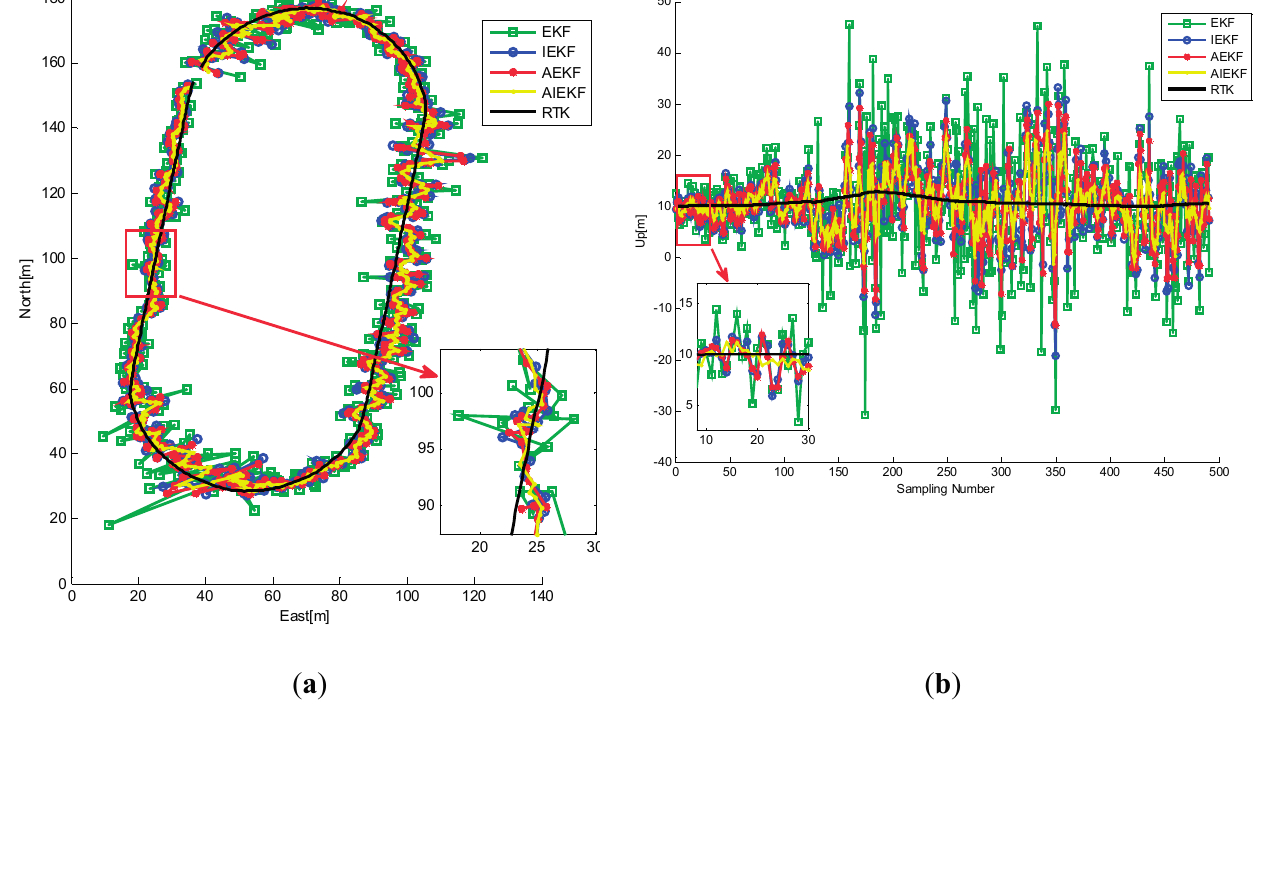
Figure 11. Trajectory of the road test obtained from RTK, EKF, IEKF, AEKF and AIEKF. ( a ) Longitude and latitude; ( b )